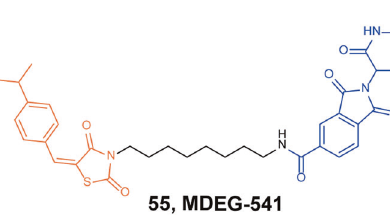
Fig. 14 The representative PROTAC targeting Myc